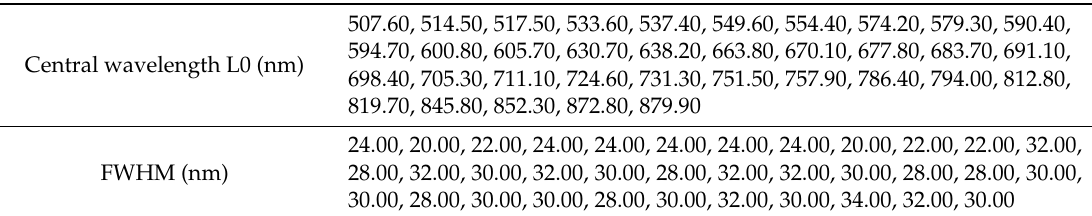
Table 1. Spectral settings of the UAV hyperspectral camera.